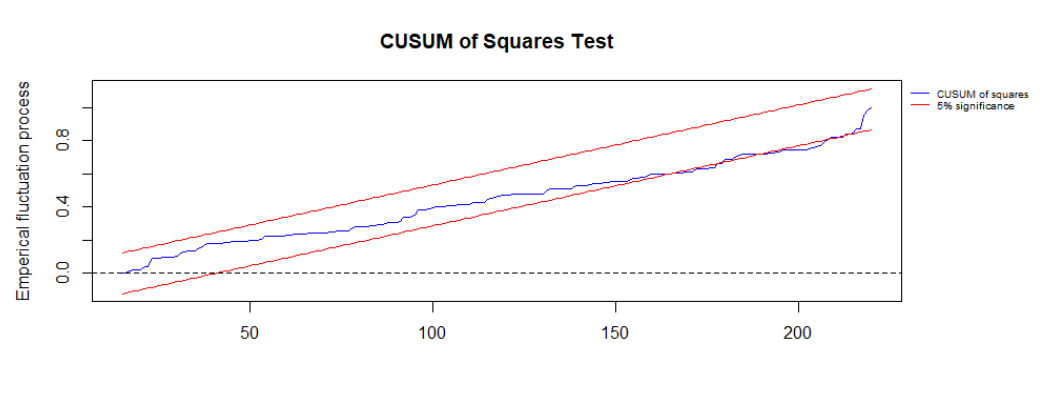
Figure 3. CUSUM of squares